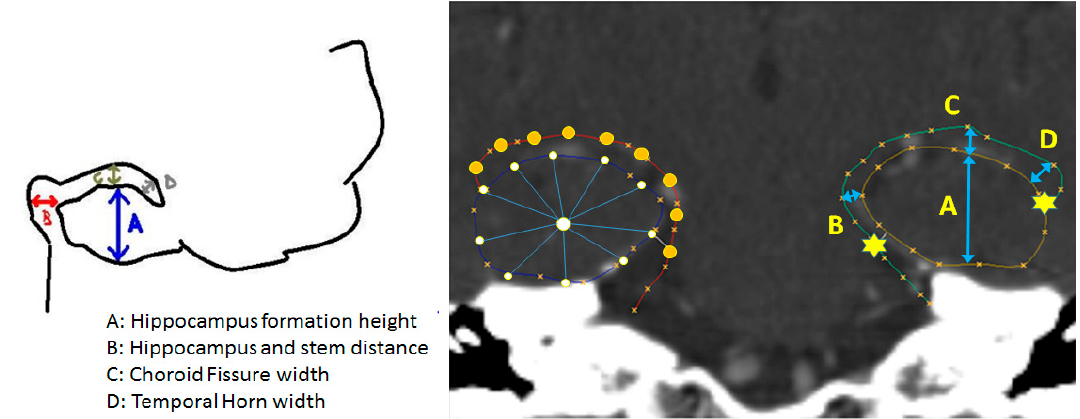
Figure 2. Annotated sketch ( left ) (A = Hippocampal formation height, B = Hippocampal and stem distance, C = Choroid fissure width, D = Temporal horn width) of topological prescription and the corresponding shape overlaid on an image ( right ). For clarity, the fiducial markers (stars) are placed on the left contour, while the regularized control points (circles) are shown on the right one.